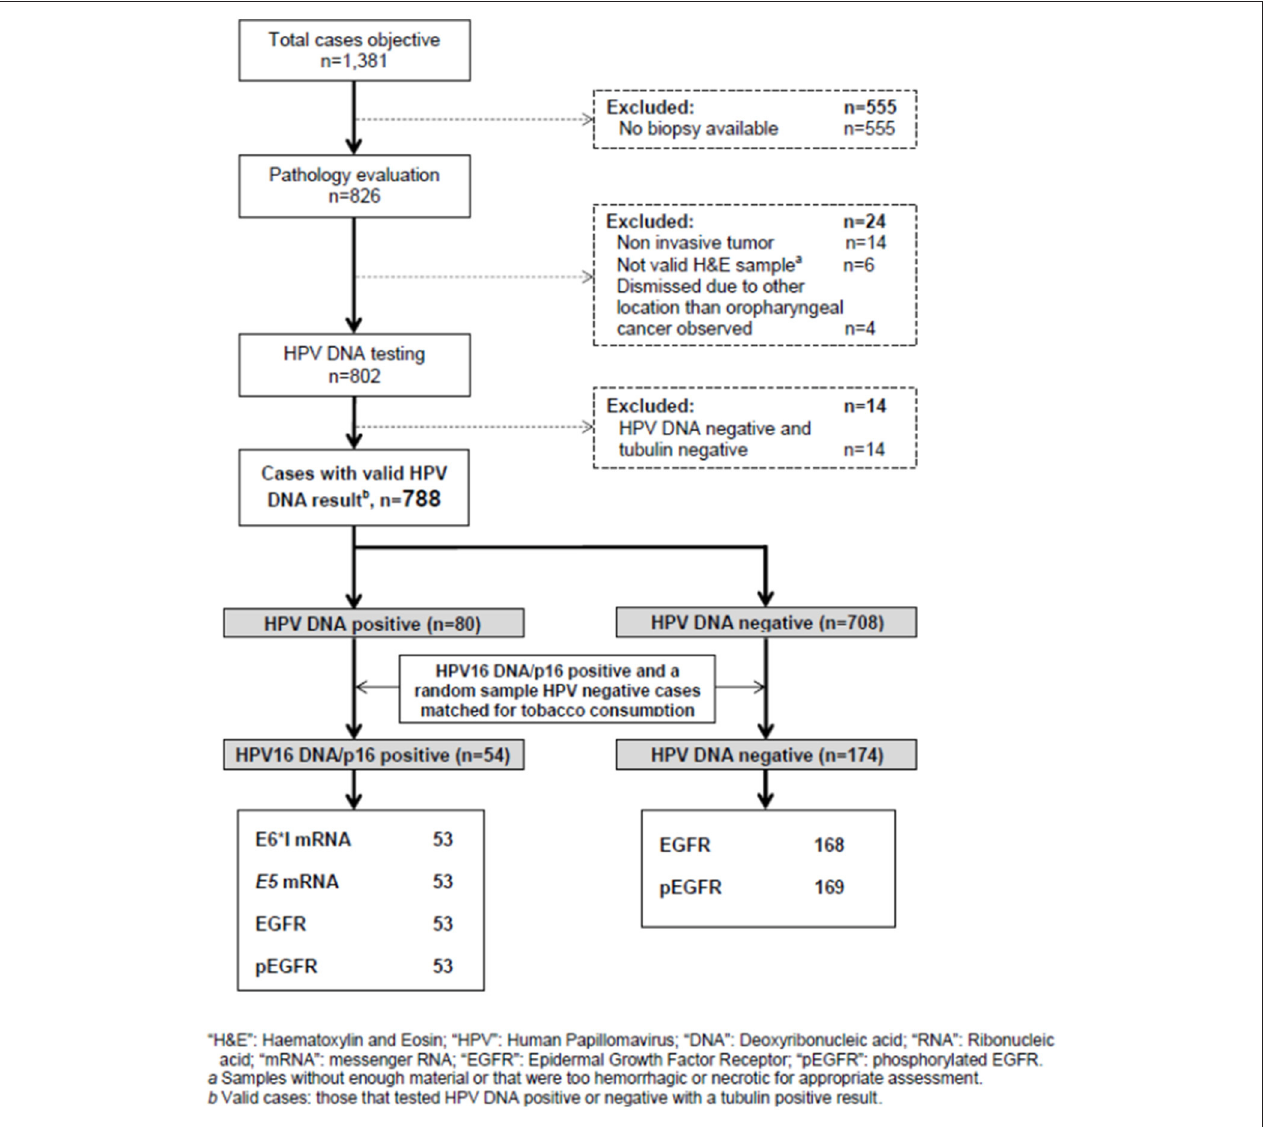
FIGURE 2 | Samples disposition and testing for HPV status and all biomarkers.